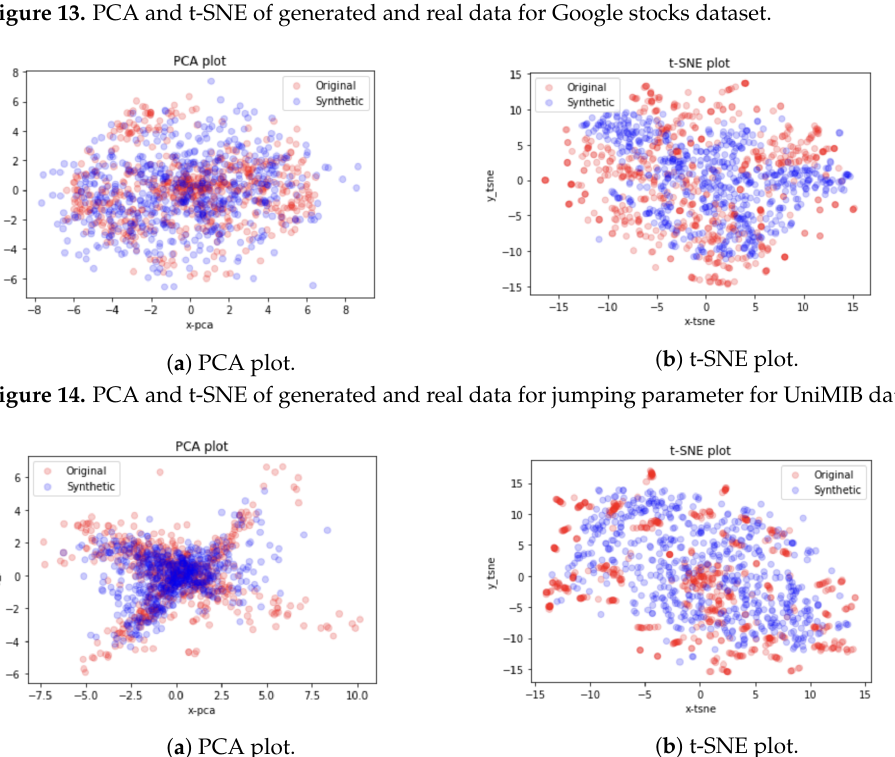
( a ) PCA plot. ( b ) t-SNE plot. Figure 15. PCA and t-SNE of generated and real data for running parameter for UniMIB dataset.